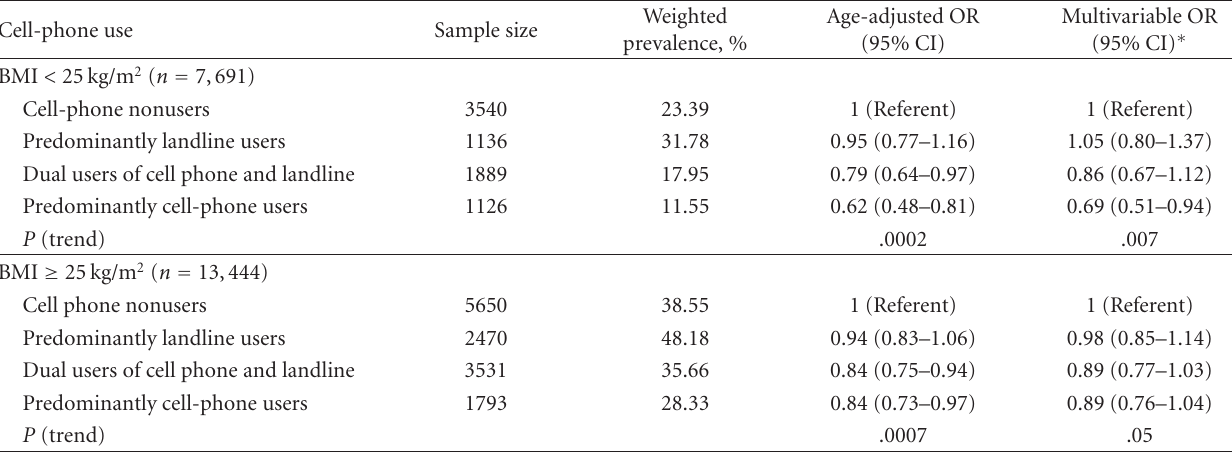
Table 6: Association between cell-phone use and hypertension by body mass index (BMI)